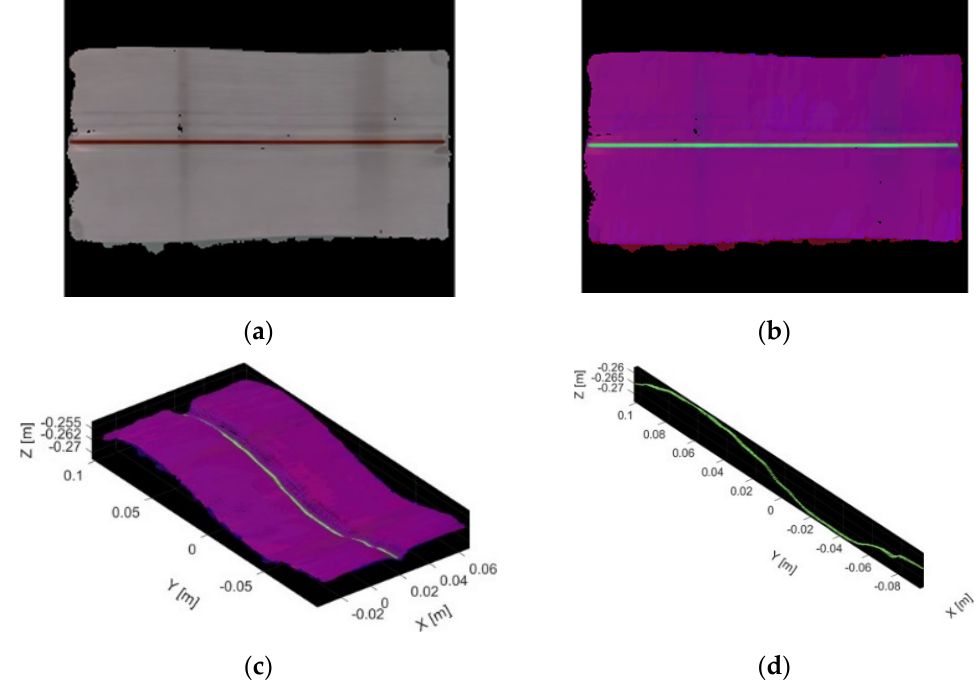
Figure 7. Color Segmentation: ( a ) RGB image; ( b ) image with HSV transformation; ( c ) point cloud with HSV data; ( d ) points of seam filter by color segmentation.